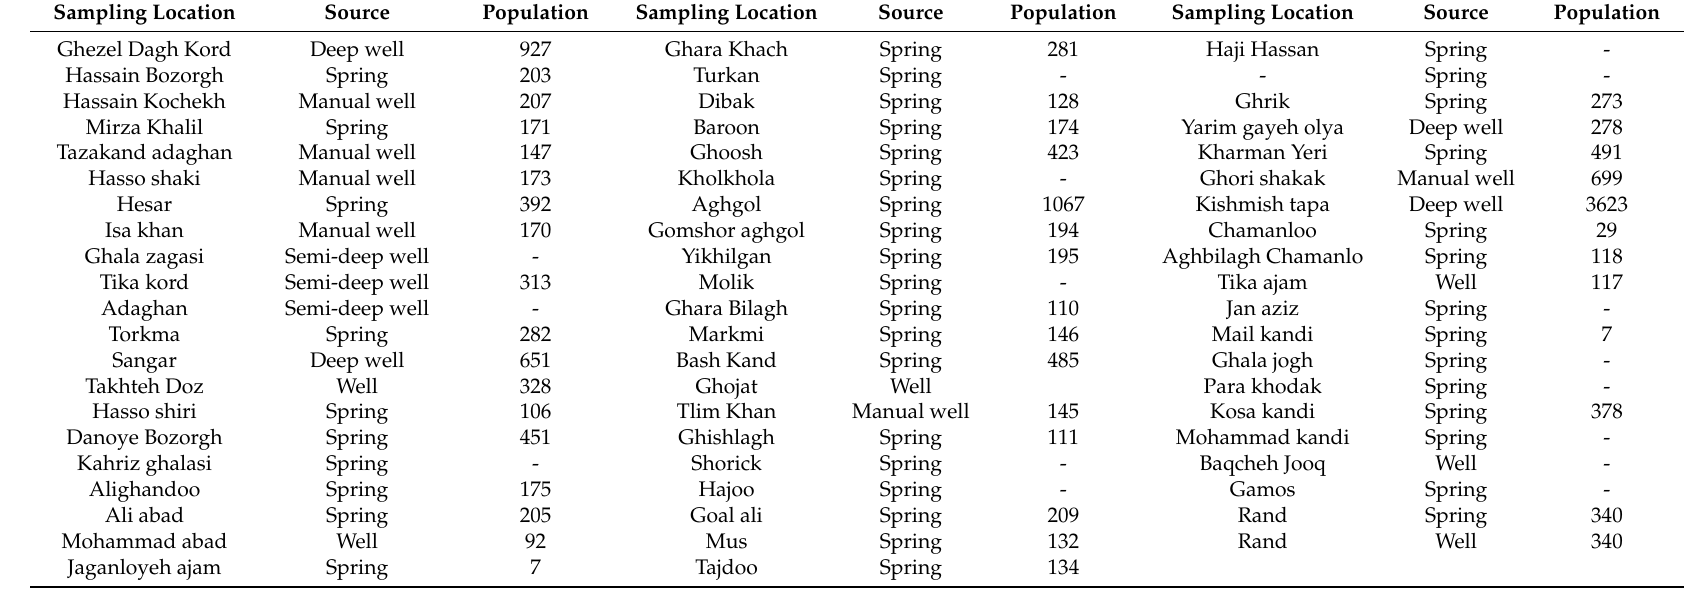
Table 2. Summary of the population and type of source drinking water of villages in the study area